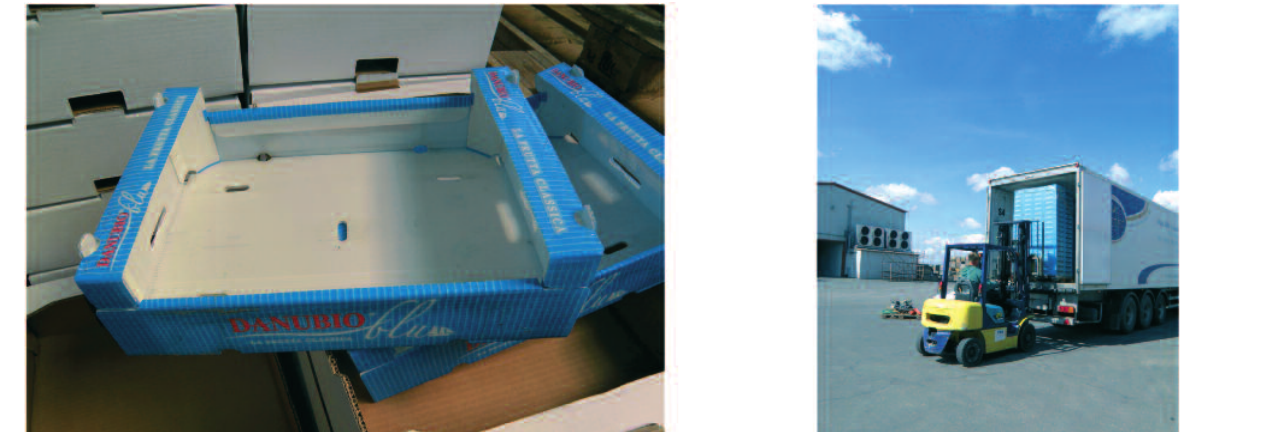
Fig. 13: The plastic bins Fig. 14: The take over of the plastic bins